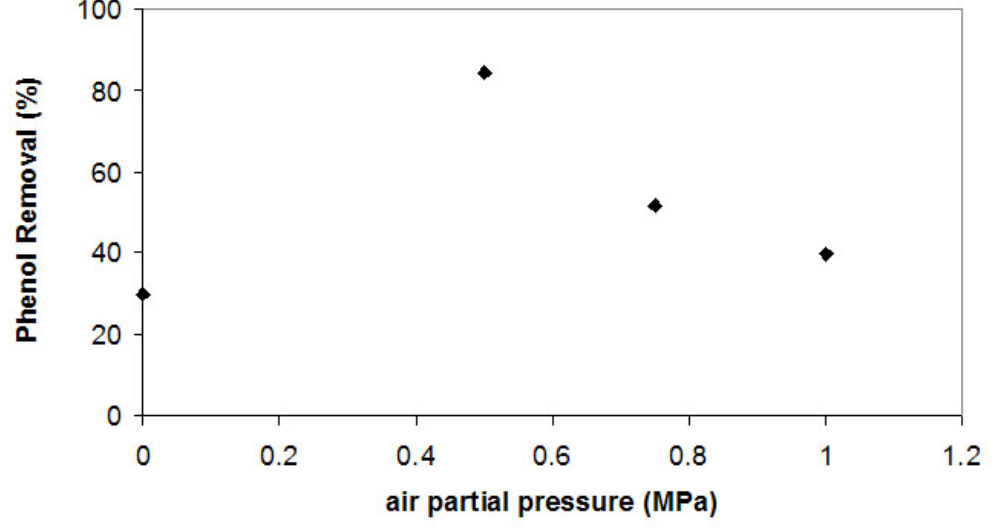
Figure 3. Phenol removal by tyrosinase CO pressure = 7.0 MPa ) at different air partial pressure.